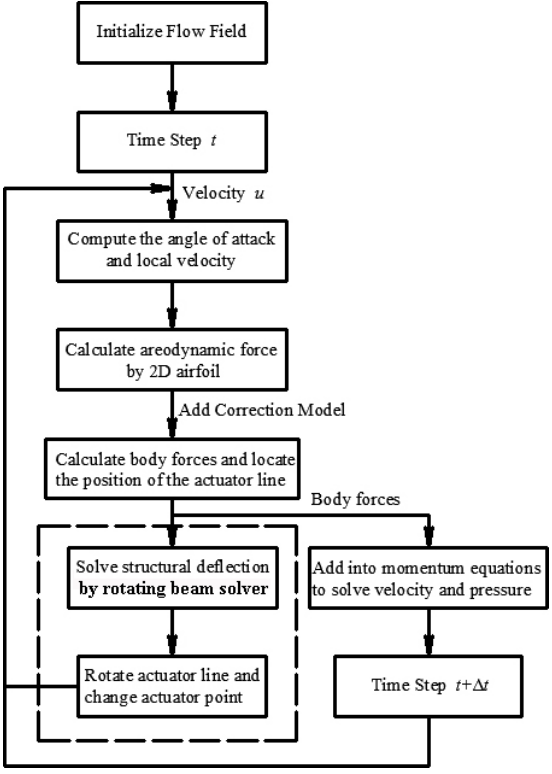
Figure 5. The computational flow chart of new elastic actuator line model.